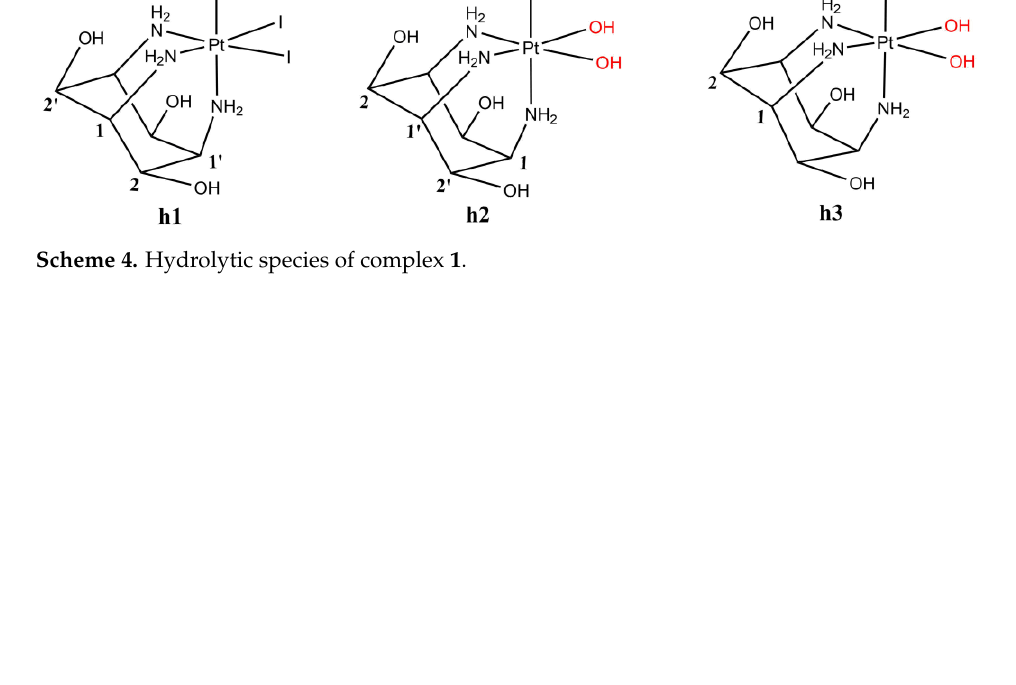
Figure 5. 1 H- 1 H COSY NMR spectrum of 1 , immediately after adding NaOD (pD = 7.8). The substitution of one I - with a solvent molecule (here OH - ) lowers the molecule symmetry to C s , and as a result, two different signals were observed for the ring hydro- gens attached to C -N and also two different signals for the ring hydrogens attached to C - O. It should be emphasized that the signal of H( C-N) ( h1- 1′ ) was observed at lower fre- quencies because the N-atom belongs to NH 2 -group coordinated trans- to the OH- ligand compared with this of the hydrogen located in the C-NH 2 -group ( h1-1 ) that is coordinated trans- to I - ligand (Figure 5). A reverse placement from high-field ( h1-2 ) to low-field ( h1- 2′ ) was observed for the signals of the ring’ hydrogens attached to C-O (Figure 5). The hydrolysis processes in the next two hours continued with the formation of the second hydrolytic species, h2, with the substitution of two I - ligands (Scheme 4). The lower C s molecular symmetry again gives four signals in its 1 H-spectrum (Table 1). In the last hy- drolytic species obtained in the system, all three iodide ligands are equivalently substi- tuted. Its higher C 3v symmetry, like the starting complex 1 , gives two signals in the 1 H- NMR spectrum, namely for H C-N ( h3-1 ) and H C-O ( h3-2 ). The 1 H- 1 H COSY experiment proved the correspondence between the individual signals and their belonging to the dif- ferent complex species. Based on the evaluation of the intensity of the signals, it was found that on the fourth day of the experiment, the main species were: 1 — 15%, h1 — 50%, h2 —